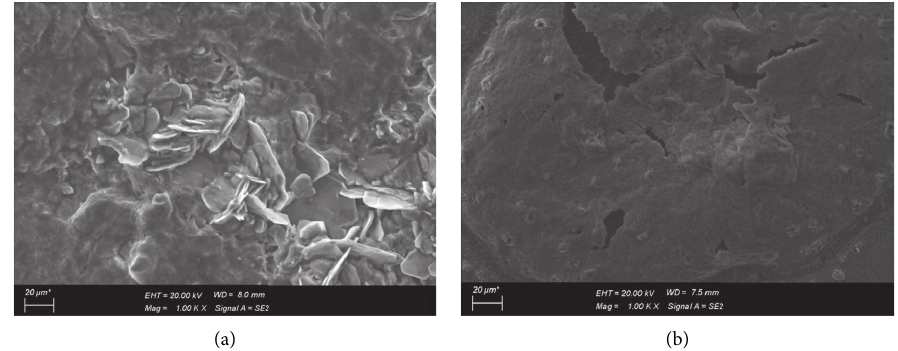
Figure 5: (a) SEM image of MoS 2 with sulphur. (b) SEM image of MoS 2 without sulphur.